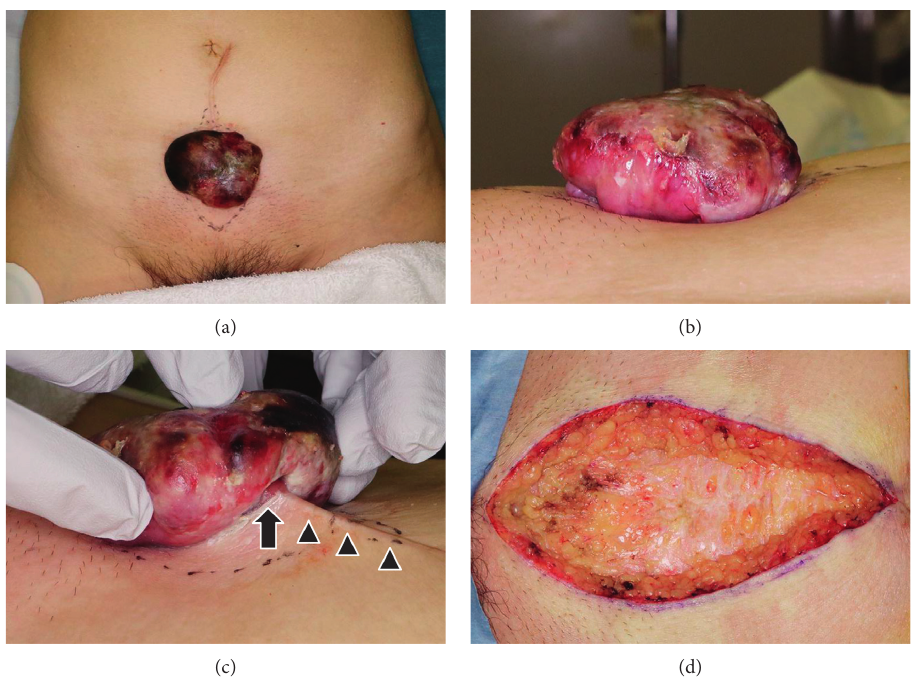
Figure 2: Frontal (a) and lateral (b) view of the tumor after three weeks. The tumor has rapidly increased in size to 6 × 6 × 2cm and protruded further. (c) The tumor is observed to be continuous with the keloid scar (arrowhead), protruding outside the body, and pe- dunculated (arrow). (d) Intraoperatively, the tumor had not invaded the abdominal cavity.